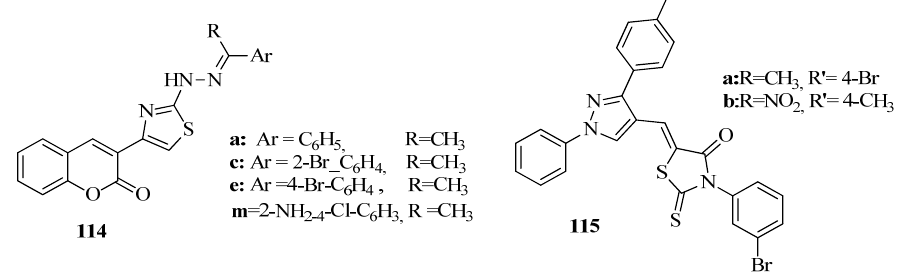
Figure 48. Structure of coumarin–thiazole 114 and pyrazole–rhodanine hybrids 115a – b